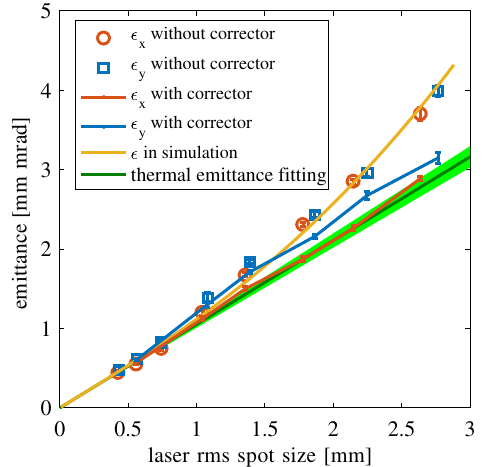
FIG. 2. Transverse emittance as a function of the laser rms spot size. Circle and square dots: Measured results without a quadru- pole corrector. Solid green line: Thermal emittance value with an error bar, extrapolated from the linear regime in the measurement. Solid yellow line: Simulated emittance by ASTRA without a quadrupole corrector. Solid red and blue lines: Measured results with a quadrupole corrector set to the proper strength and rotation angle to fully cancel the coupled-transverse-dynamics